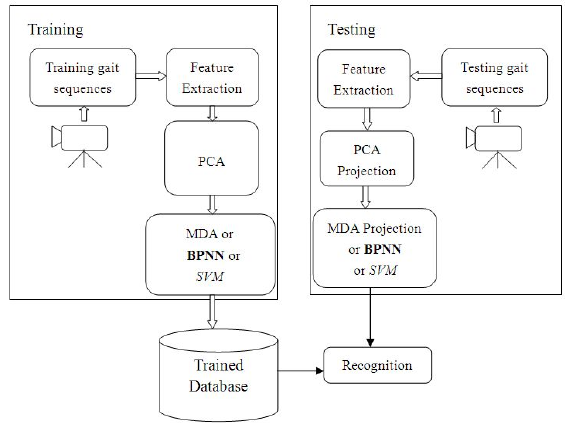
Fig. 1. Overview of our gait recognition